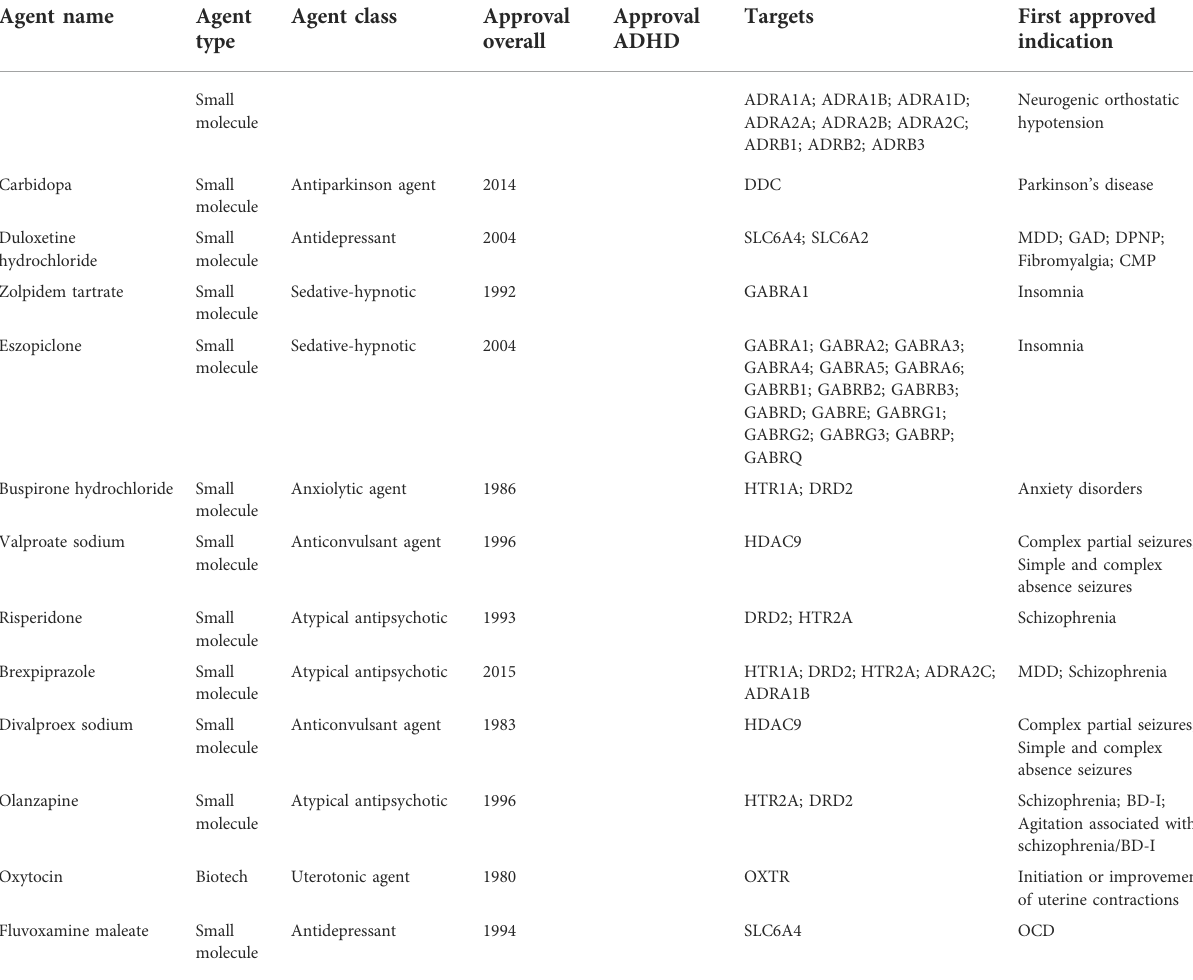
targets. Receptor and transporter target types jointly represent more than 80% of all drug target types in the included trials. These trends partially correspond to overall trends in drug discovery, where receptors also represent the main drugged class (Rask-Andersen et al.,